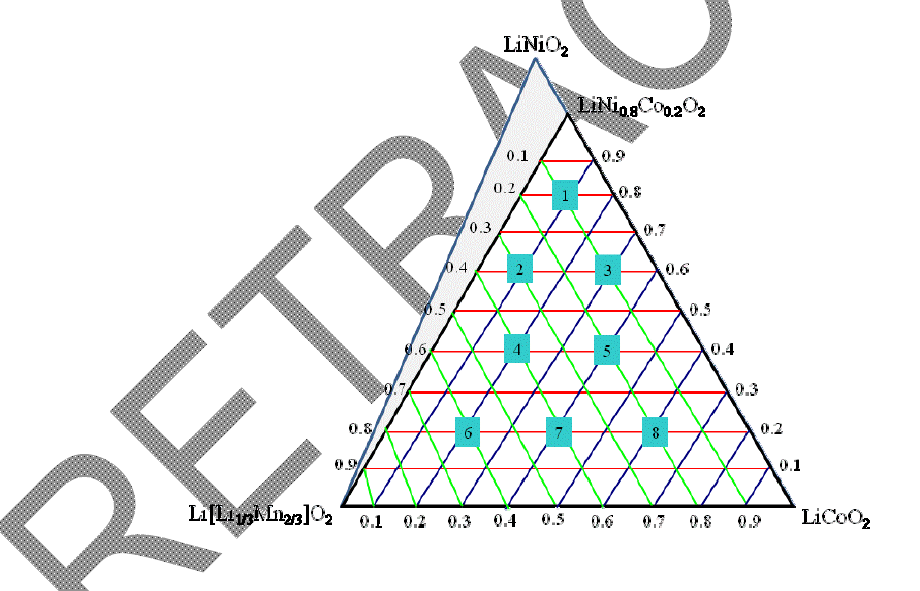
Figure 1. Compositional ternary diagram representing regions of materials